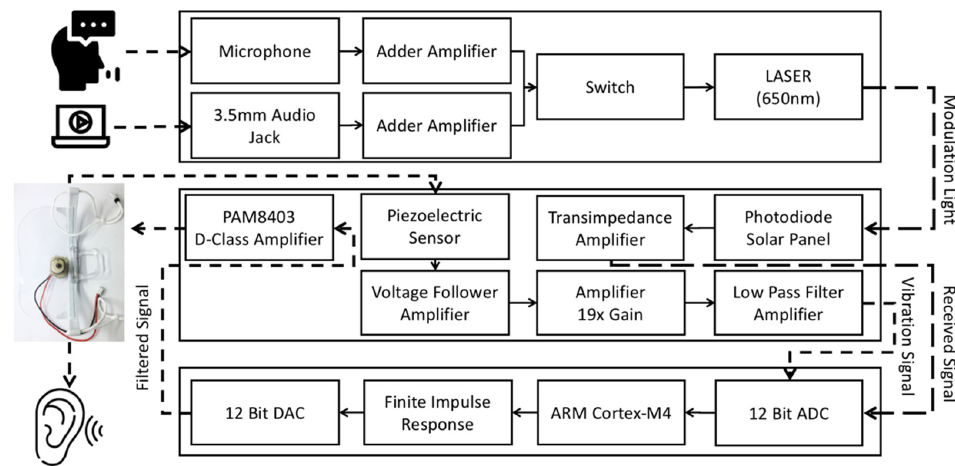
Figure 7. System architecture.